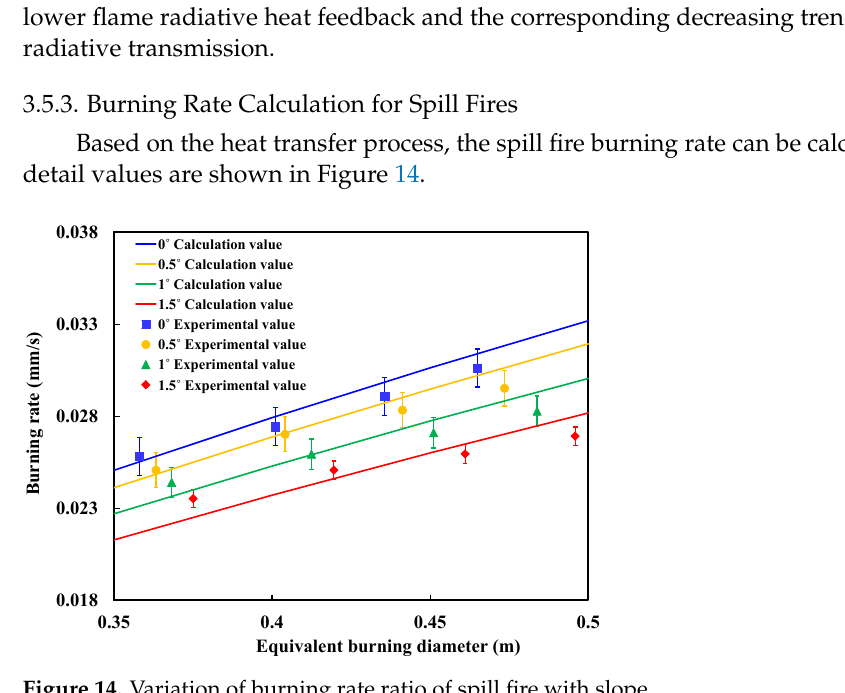
Figure 13. Variation of n-heptane flame feedback radiation transmission with slope.